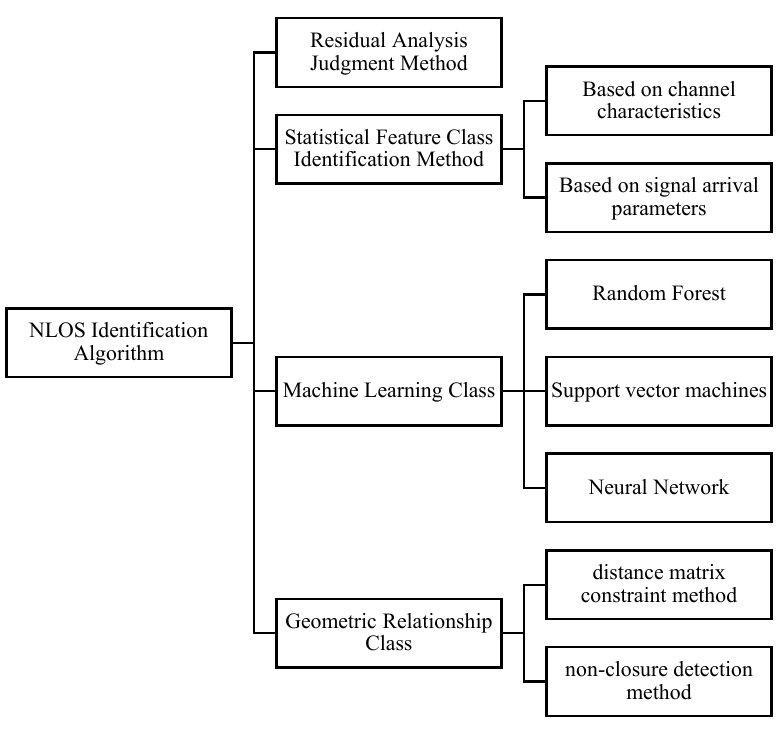
Figure 2. NLOS recognition algorithm.